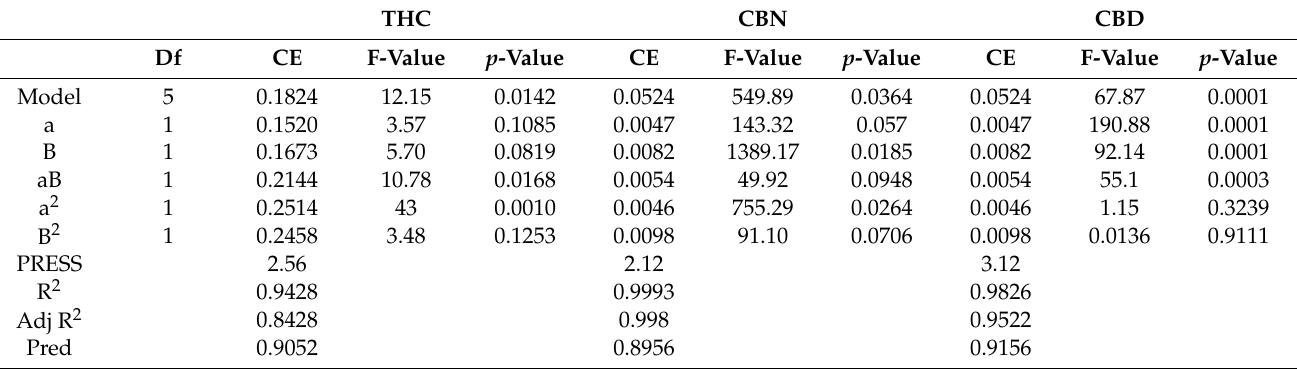
Table 2. Analysis of variance (ANOVA) of the regression model for the recovery of cannabinoid compounds. THC CBN